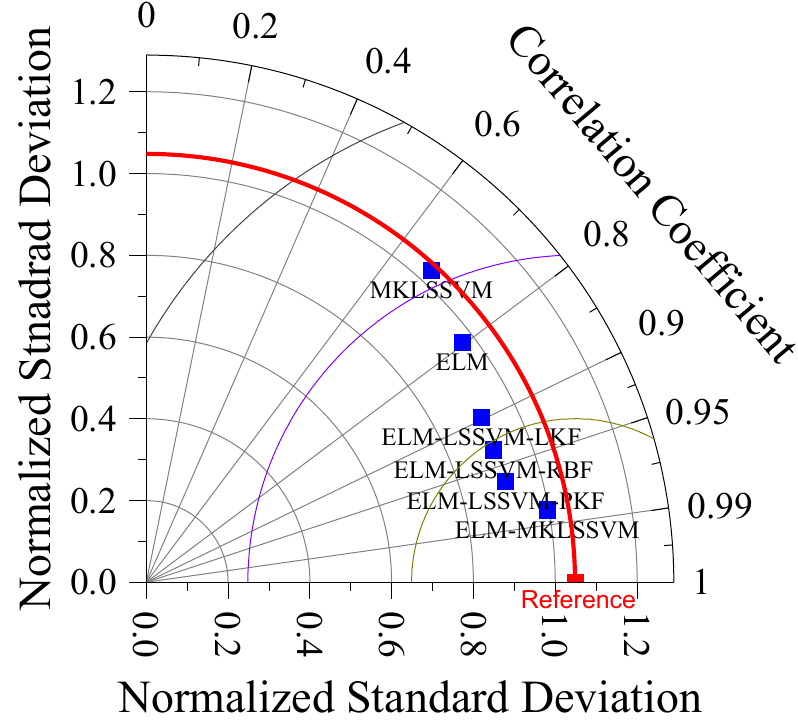
Figure 6. Comparison of the accuracy of models based on the Taylor diagram.